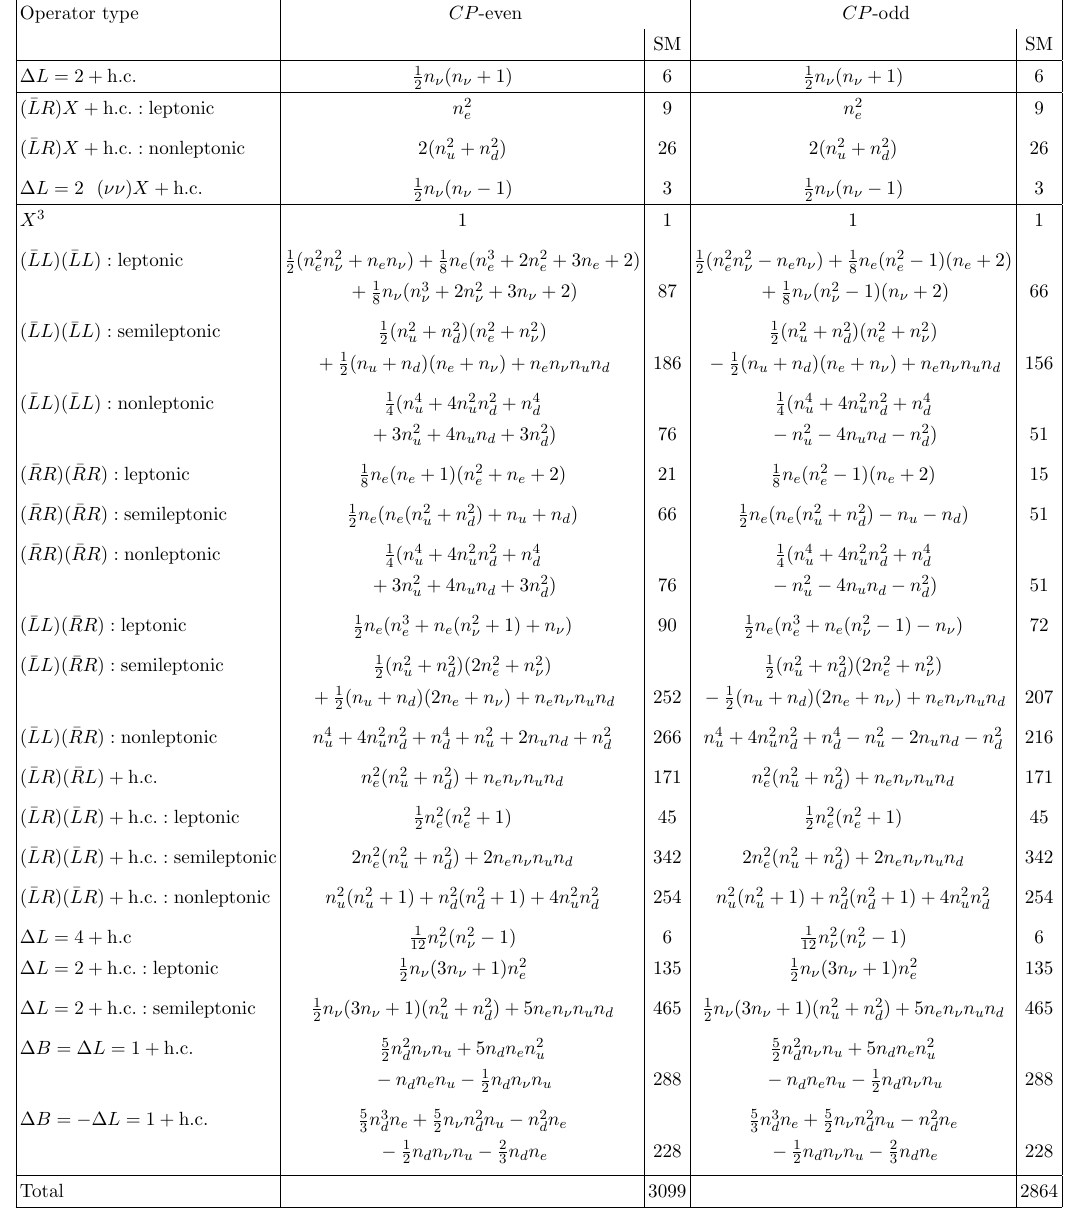
Table 22 . Number of operators in LEFT at dimensions three, five, and six, divided into CP -even and CP -odd operators. The number of operators is given for an arbitrary number of neutrino flavors n ν , charged lepton flavors n e , u -type quark flavors n u , and d -type quark flavors n d , and for the case of SM LEFT with n ν = 3, n e = 3, n u = 2, and n d = 3. The LEFT operators in each category are given explicitly in tables